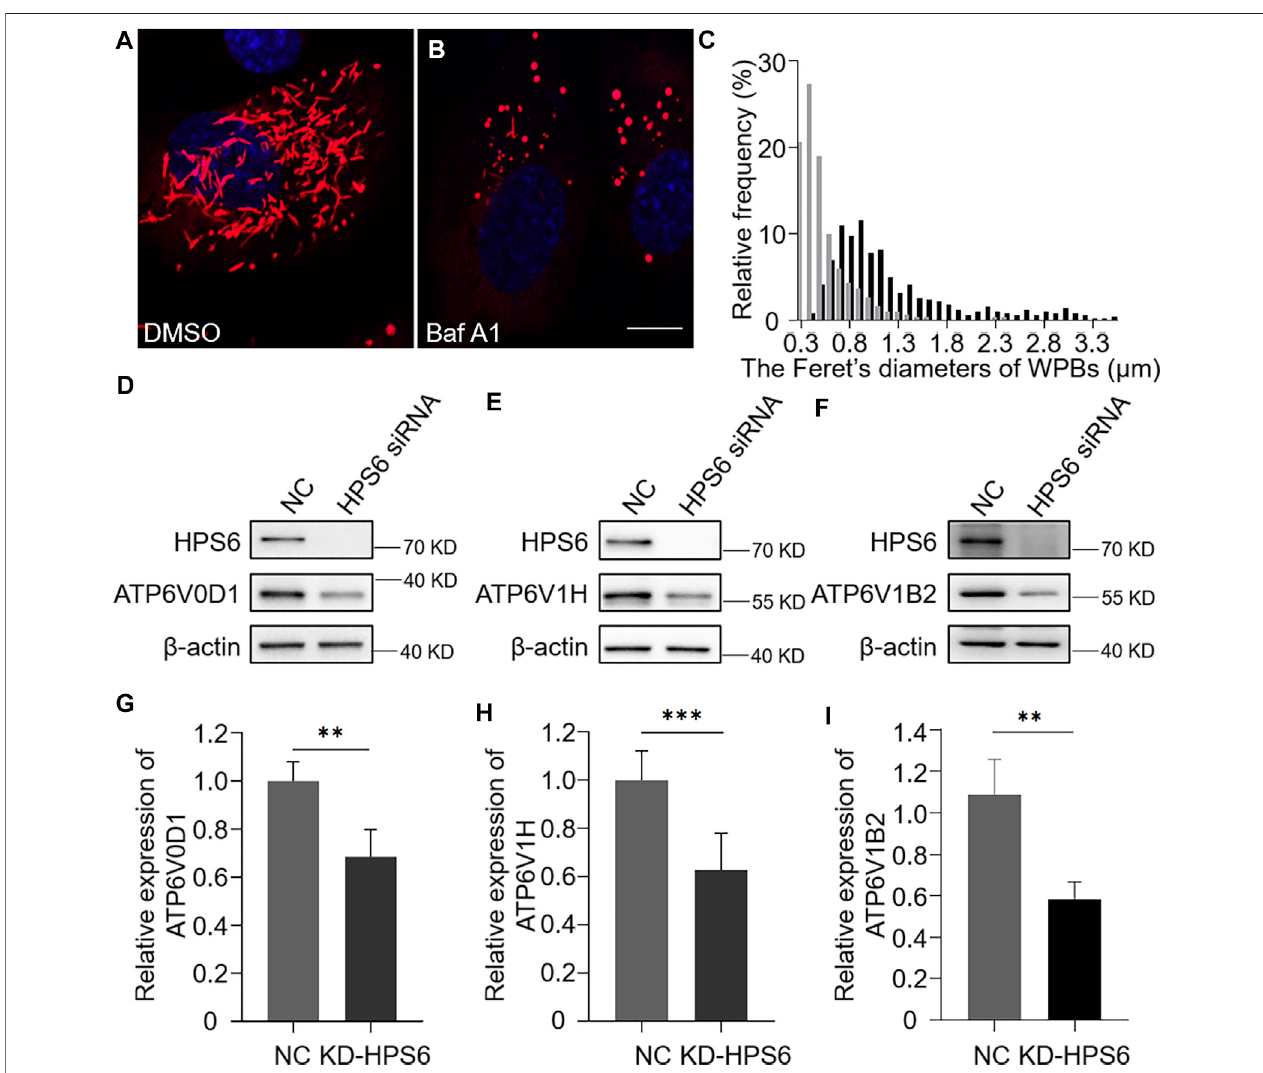
FIGURE 4 | v-ATPase is compromised in KD-HPS6 human umbilical vein endothelial cells (HUVECs). Pharmacological inhibition of the v-ATPase caused the Weibel – Paladebodies(WPBs)tolosetheirelongatedshapes.DMSOorv-ATPaseinhibitor,BafA1(200 nM),wasadministered1 hbeforecell fi xationby4%PFA( n =20 per group). ( A , B ) Immuno fl uorescence images of DMSO-treated ( A ) and Baf A1-treated cells labeled against vWF (red) and nucleus (DAPI, blue). Scale bar, 10 μ m. ( C ) Feret ’ sdiameterofWPBsateachgroupofHUVECswasanalyzedquantitatively(DMSO:502WPBs,gray;BafA1:300 WPBs,black).( D – I )siRNA-mediatedHPS6 knockdown suppressed the expression of ATP6V0D1, ATP6V1H, and ATP6V1B2, three subunits of v-ATPase ( n = 8 per group, ** p < 0.01,*** p < 0.001). Data were expressed as mean ± SEM. Three independent experiments were performed.